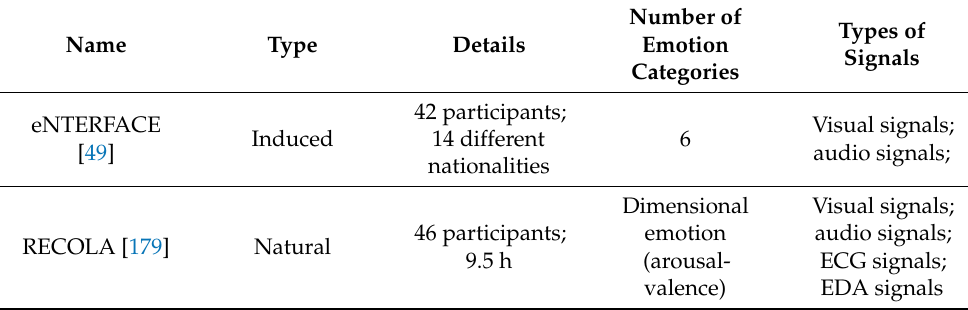
Table 6. Datasets for multi-modal emotion